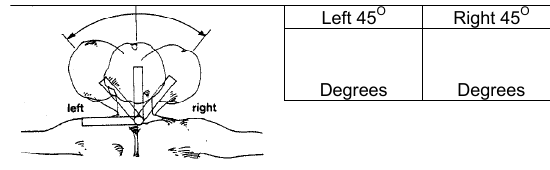
Figure 4. Neck lateral bending range of motion